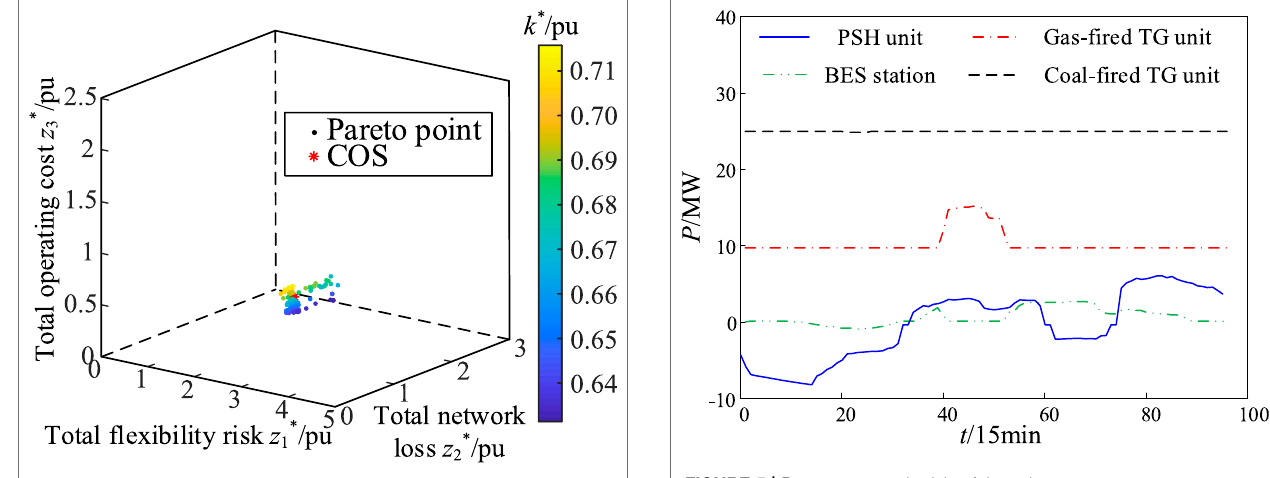
FIGURE 4 | Pareto frontier obtained by the NSGA-II algorithm.